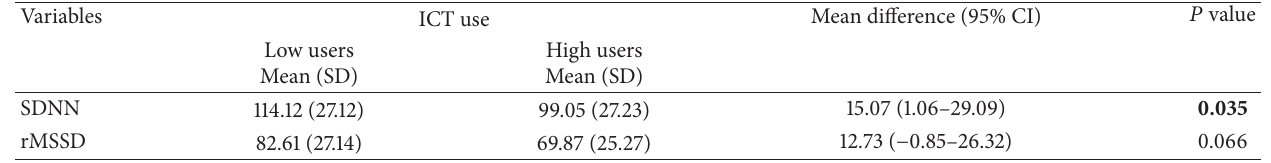
Table 2: Unadjusted means of SDNN (ms) and rMSSD (ms) by ICT use.